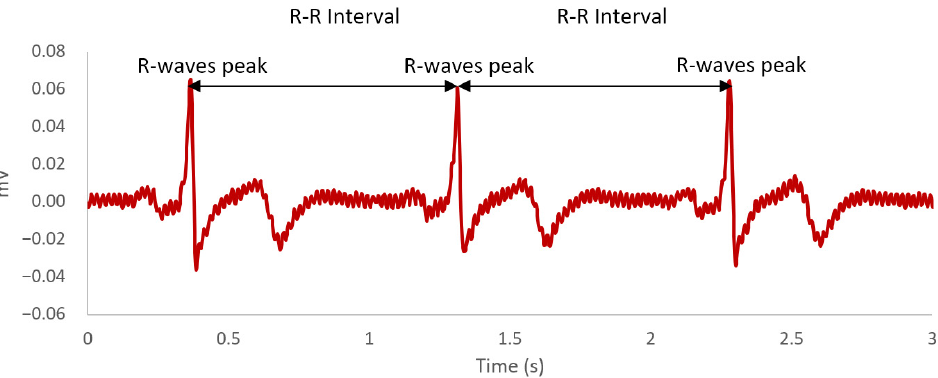
Figure 1. An example of a heartbeat waveform across a 3-second time window. The R-wave peaks are the most positive deflection observed in the waveform. The R-R intervals are the time difference between each R-wave peaks.